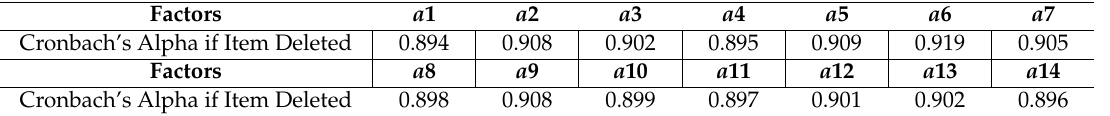
Table 3. Project total statistical